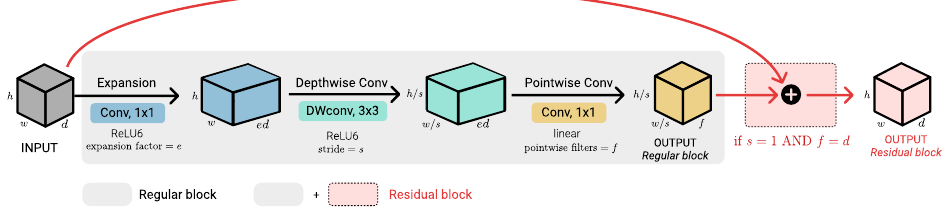
Figure 13. MobileNetV2 building blocks. Idea: (1) uncompress recived data (2) filter data using the lightweighted depth-wise convolution (3) compress data to low-dimensional representation (4) combine input data with new compressed data representation. Point-wise convolutional layer in MobileNetV2 architecture is also known as the projection layer since it projects data with large number of channels into smaller-depth output ( ed >> f ).